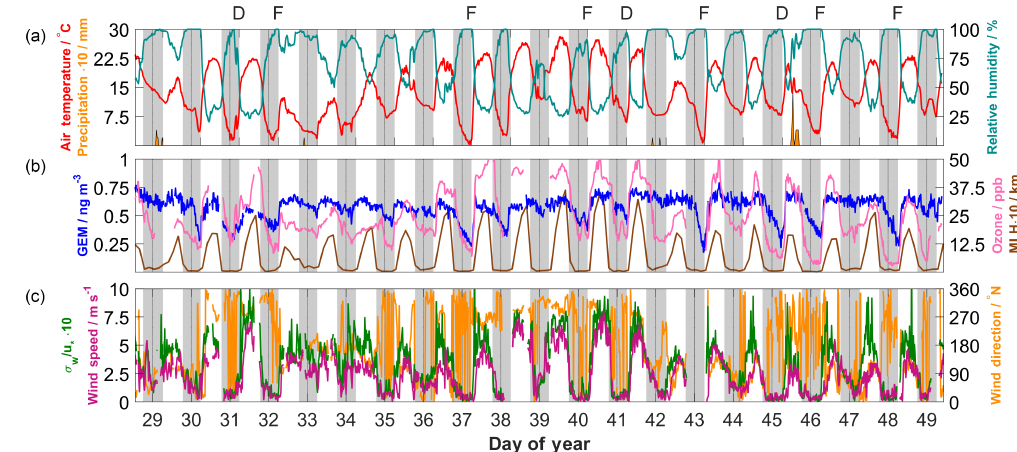
Figure 1. 60min averaged meteorological variables and ambient GEM/O 3 during the campaign. Colours for each variable match those on the axis label. Shading represents nocturnal periods (net shortwave < 20Wm − 2 ). Observations of dew and fog are denoted above the upper panel by “D” and “F”,